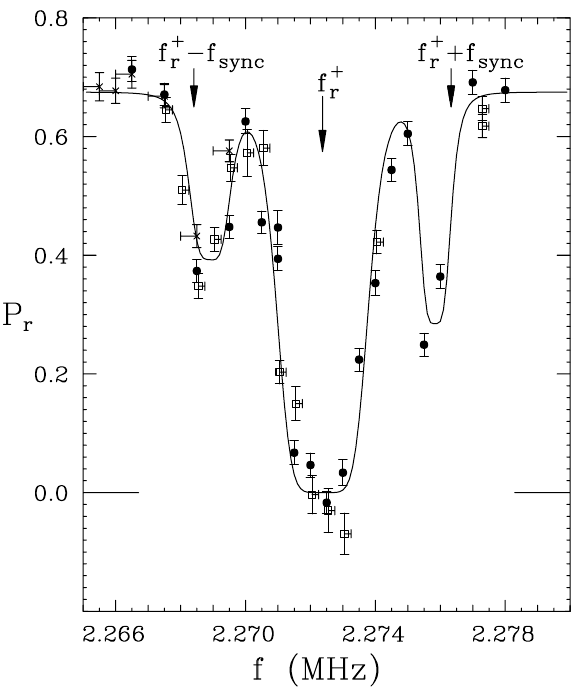
FIG. 2. The measured radial proton polarization at 104.1 MeV is plotted against the rf solenoid’s frequency. The different symbols correspond to slightly different snake solenoid cur- rents; the horizontal bars indicate the frequency’s renormaliza- tion to a constant snake current [20]. The curve is a fit using a third-order Lorentzian for the primary resonance and two un- equal second-order Lorentzians for the synchrotron